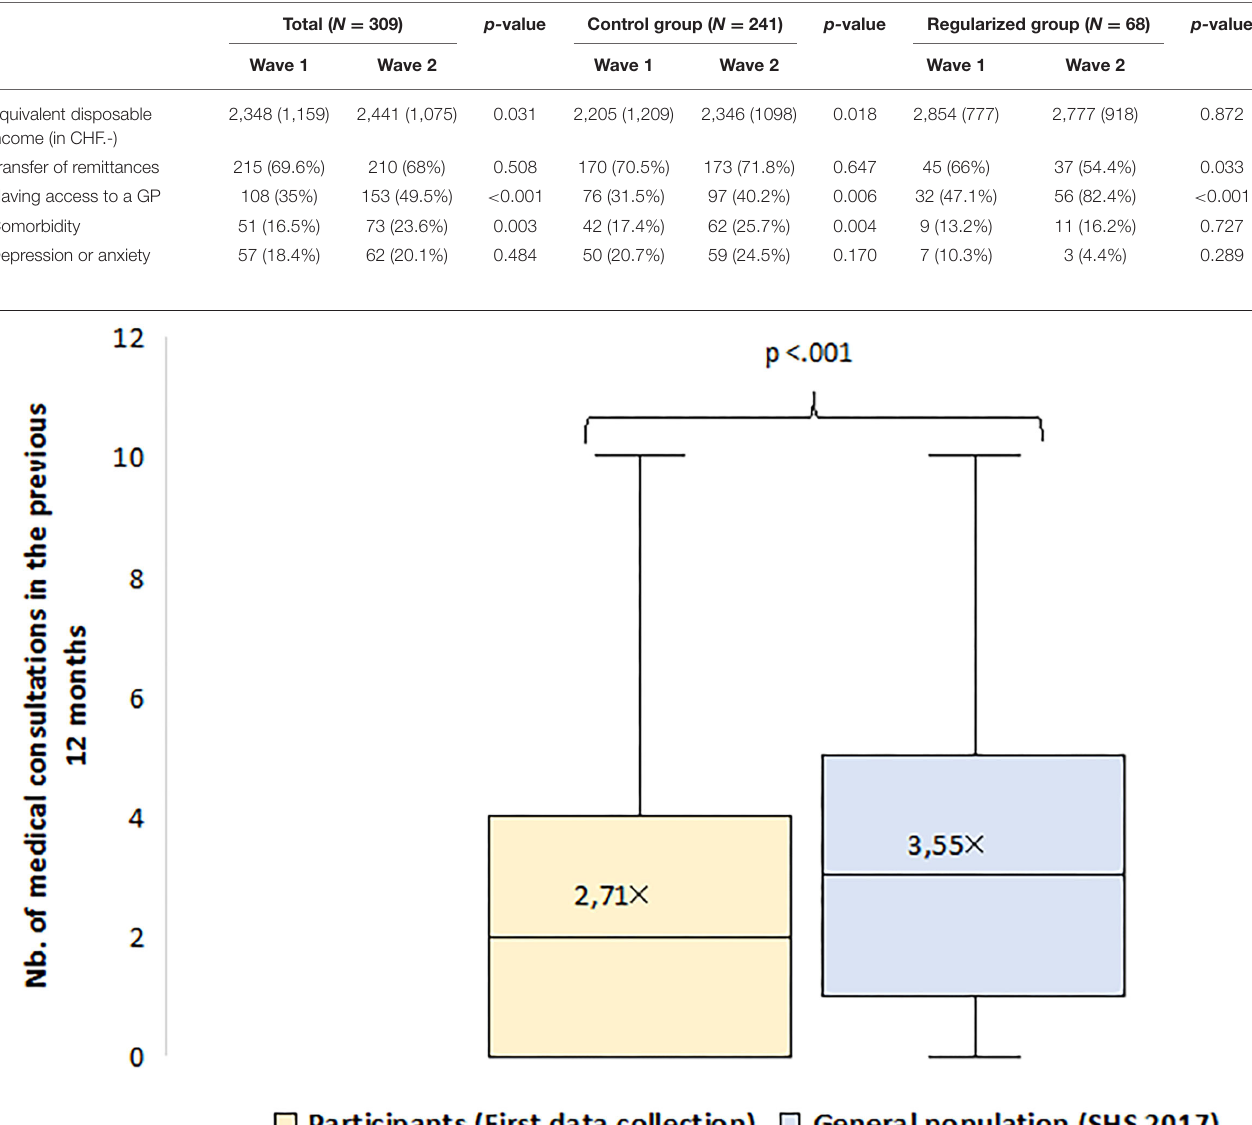
TABLE 2 | Levels of enabling and health needs factors at each period, stratified by residence status.